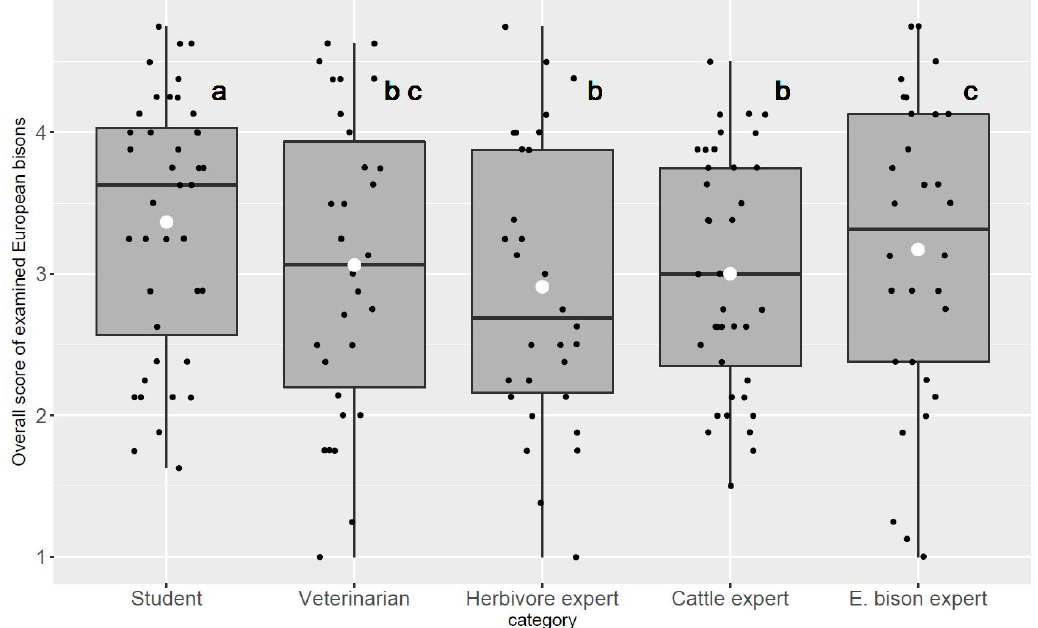
Figure 3. Box and whisker plots of the overall scores per animal per assessors’ category. The box is bounded on the top by the third quartile and on the bottom by the first quartile; the median divides the box; the whiskers represent observations outside the 9–91 percentile range. Raw data are dot-plotted as jitters. White dots indicate the means. Different letters in black indicate significant differences among category score means (Tukey Contrasts, p < 0.05; Bonferroni–Holm correction of all-pair multiple